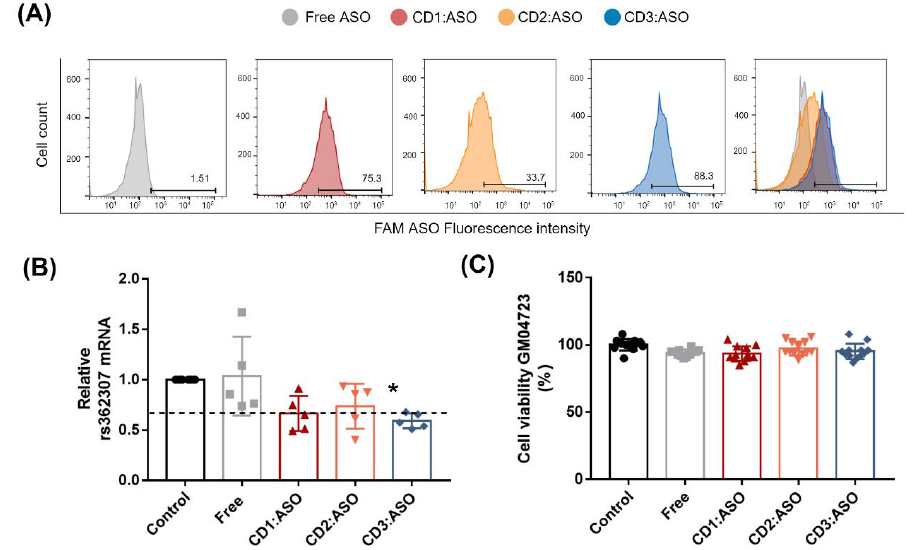
Figure 8. Screening and biological characterization of cyclodextrins (CDs):ASO nanocomplexes. ( A ) Fibroblasts from an HD patient (GM04723) heterozygous at rs362307 were treated with ASO alone or complexed with CDs (100 nM final concentration) for 6 h and the cellular uptake was confirmed by flow cytometry. ( B ) mRNA levels of rs362307 were measured 72 h post-transfection by SYBR Green qPCR and normalized to GAPDH. Mean ± S.E.M of 5 technical replicates performed in duplicate. ( C ) Effect of the formulations in the viability of cells treated during 72 h with CDs loaded with HTT ASO, MR 10:1, 100 nM per well. Living cells were determined using a CellTiter-FLuor assay and expressed as a % of the control. Mean ± S.E.M of 4 technical replicates performed in triplicate. One-way ANOVA with Tukey’s multiple comparisons test. * p < 0.05.